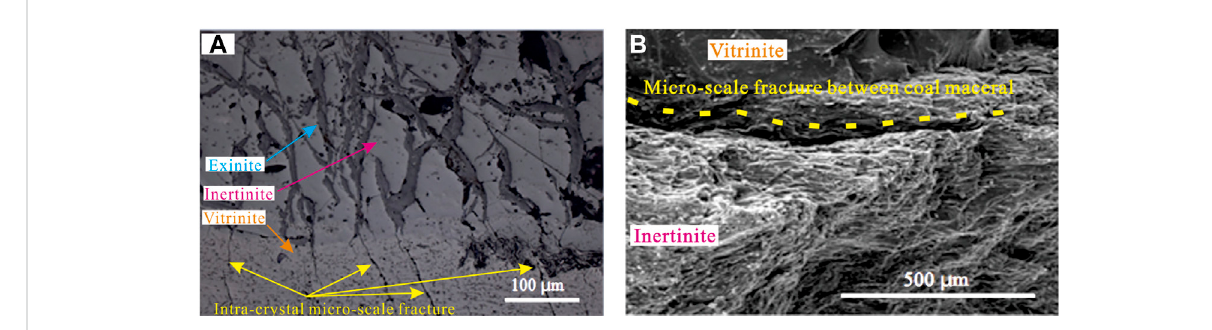
FIGURE 9 Micro-fractures developed in the coal maceral: (A) , vitrinite maceral; (B) , inertinite macerals.